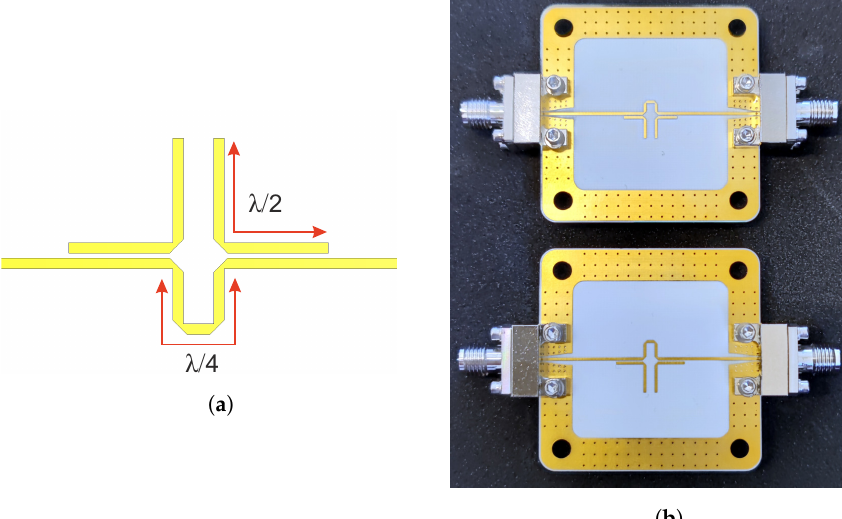
Figure 6. ( a ) Simulation model and ( b ) manufactured notch filters with end launch SMA connectors.